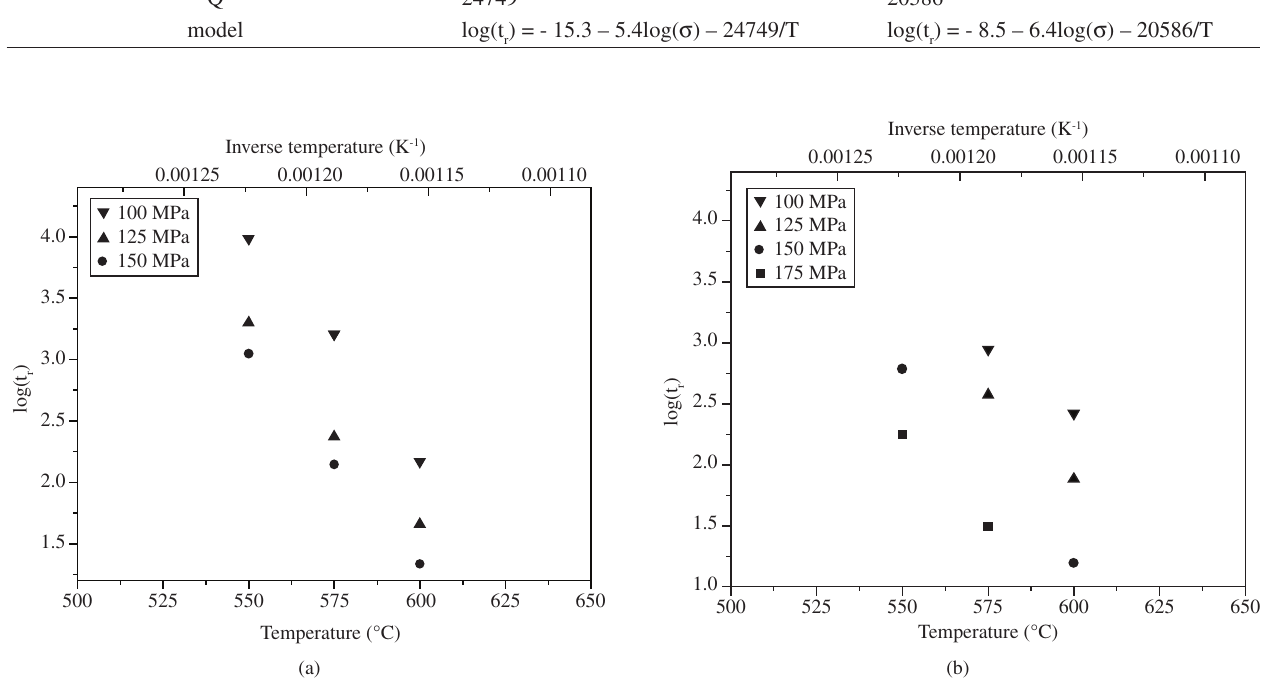
Figure 1. Results of the creep test: a) ISAM condition; and b) ISAMW